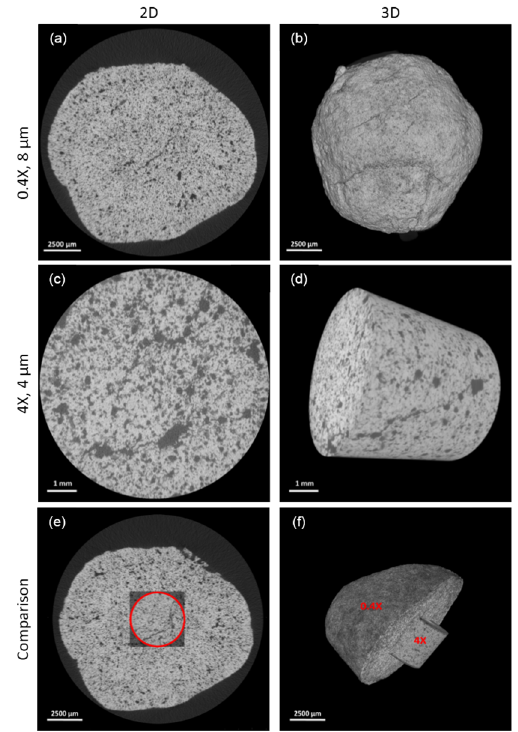
Figure 5. 1 st stage of analysis with different lenses and resolutions. Left column: representative 2D layers. Right column: corresponding 3D volumes. (a, b) 0.4X (8 µm); (c, d) 4X (4 µm); (e, f) comparison between 4X and 0.4X areas and volumes.